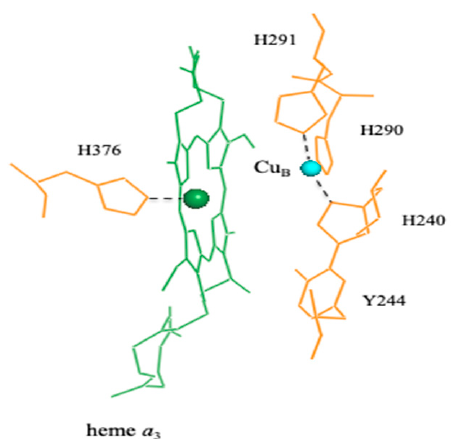
(Figures 1 and 2).